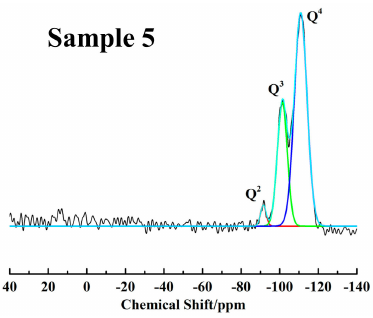
Figure 7. Solid state 29 Si MAS NMR spectra of silica aerogels fitted by Gaussian